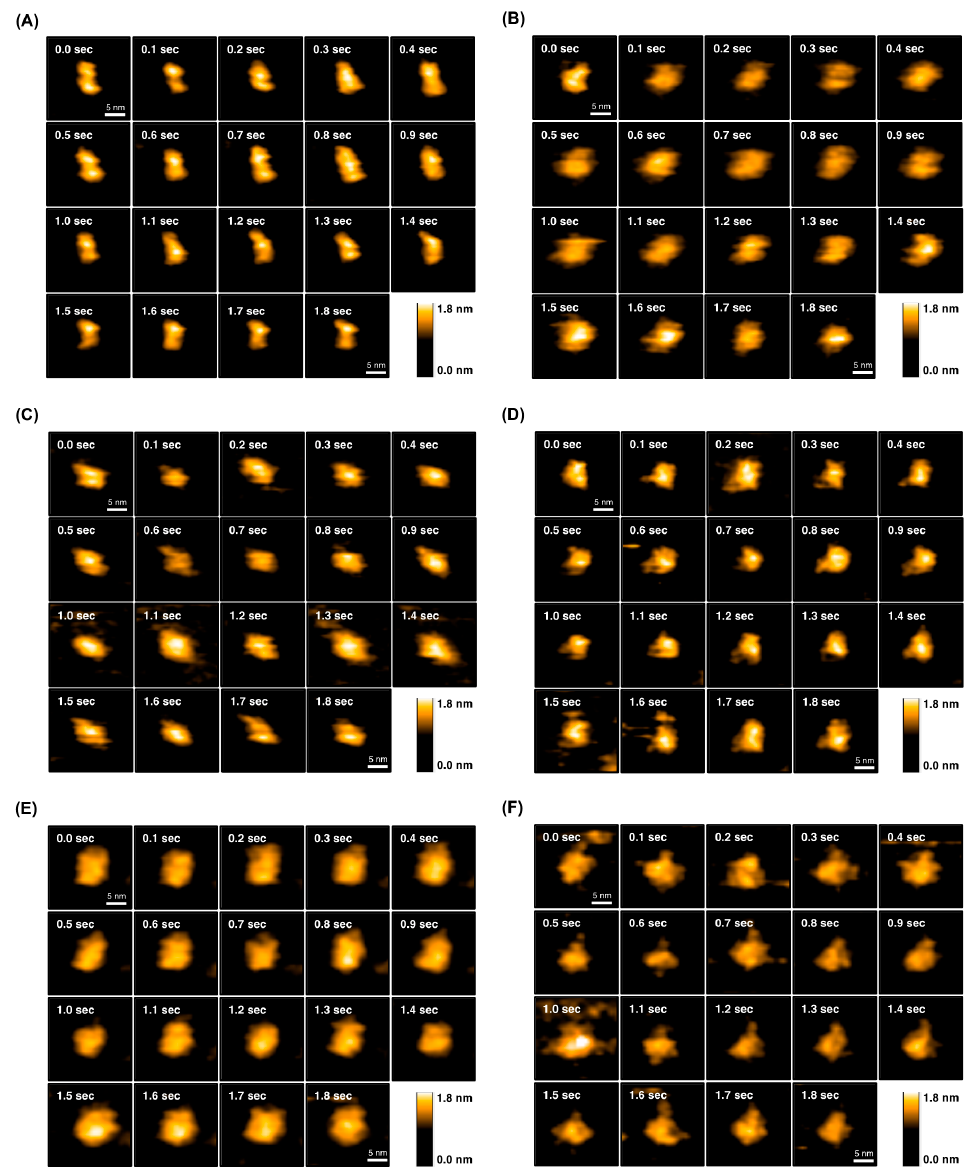
Figure 7. HS-AFM images of AGE73scFv, 73MuL-V94A, and 73MuH19. HS-AFM images of AGE73scFv, 73MuL-V94A, and 73MuH19 are shown in the absence ( A , C , E ) and presence ( B , D , F ) of CBZ-GA-pyridine, respectively.